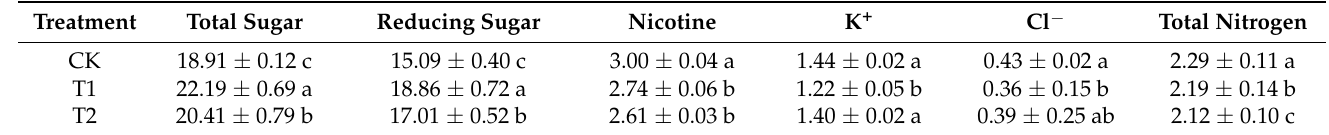
Table 3. Comparison of chemical composition of flue-cured tobacco after curing (%).